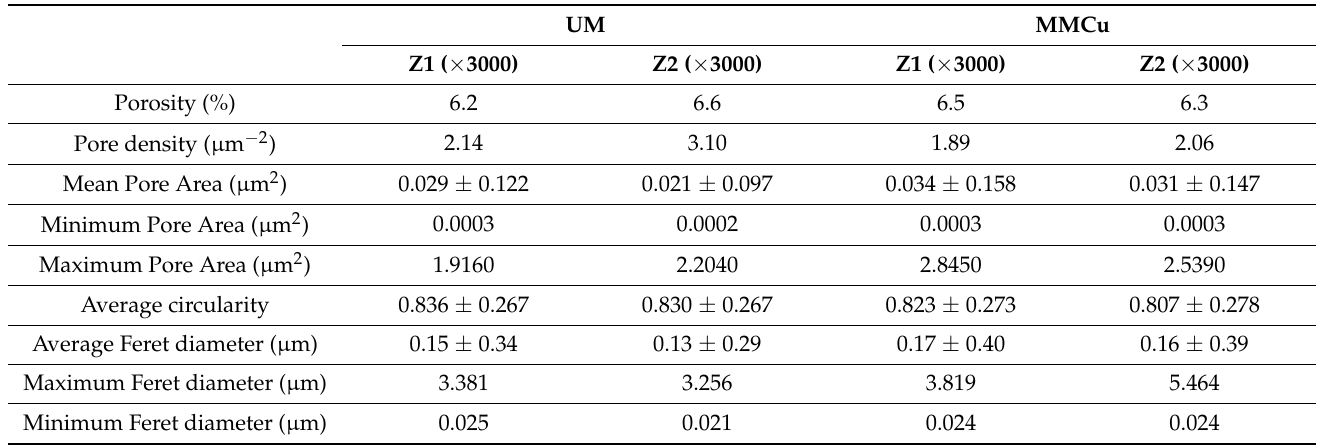
Table 1. Porous properties estimated in two zones (Z1 and Z2), for the membranes described in this work (magnification of ×3000).